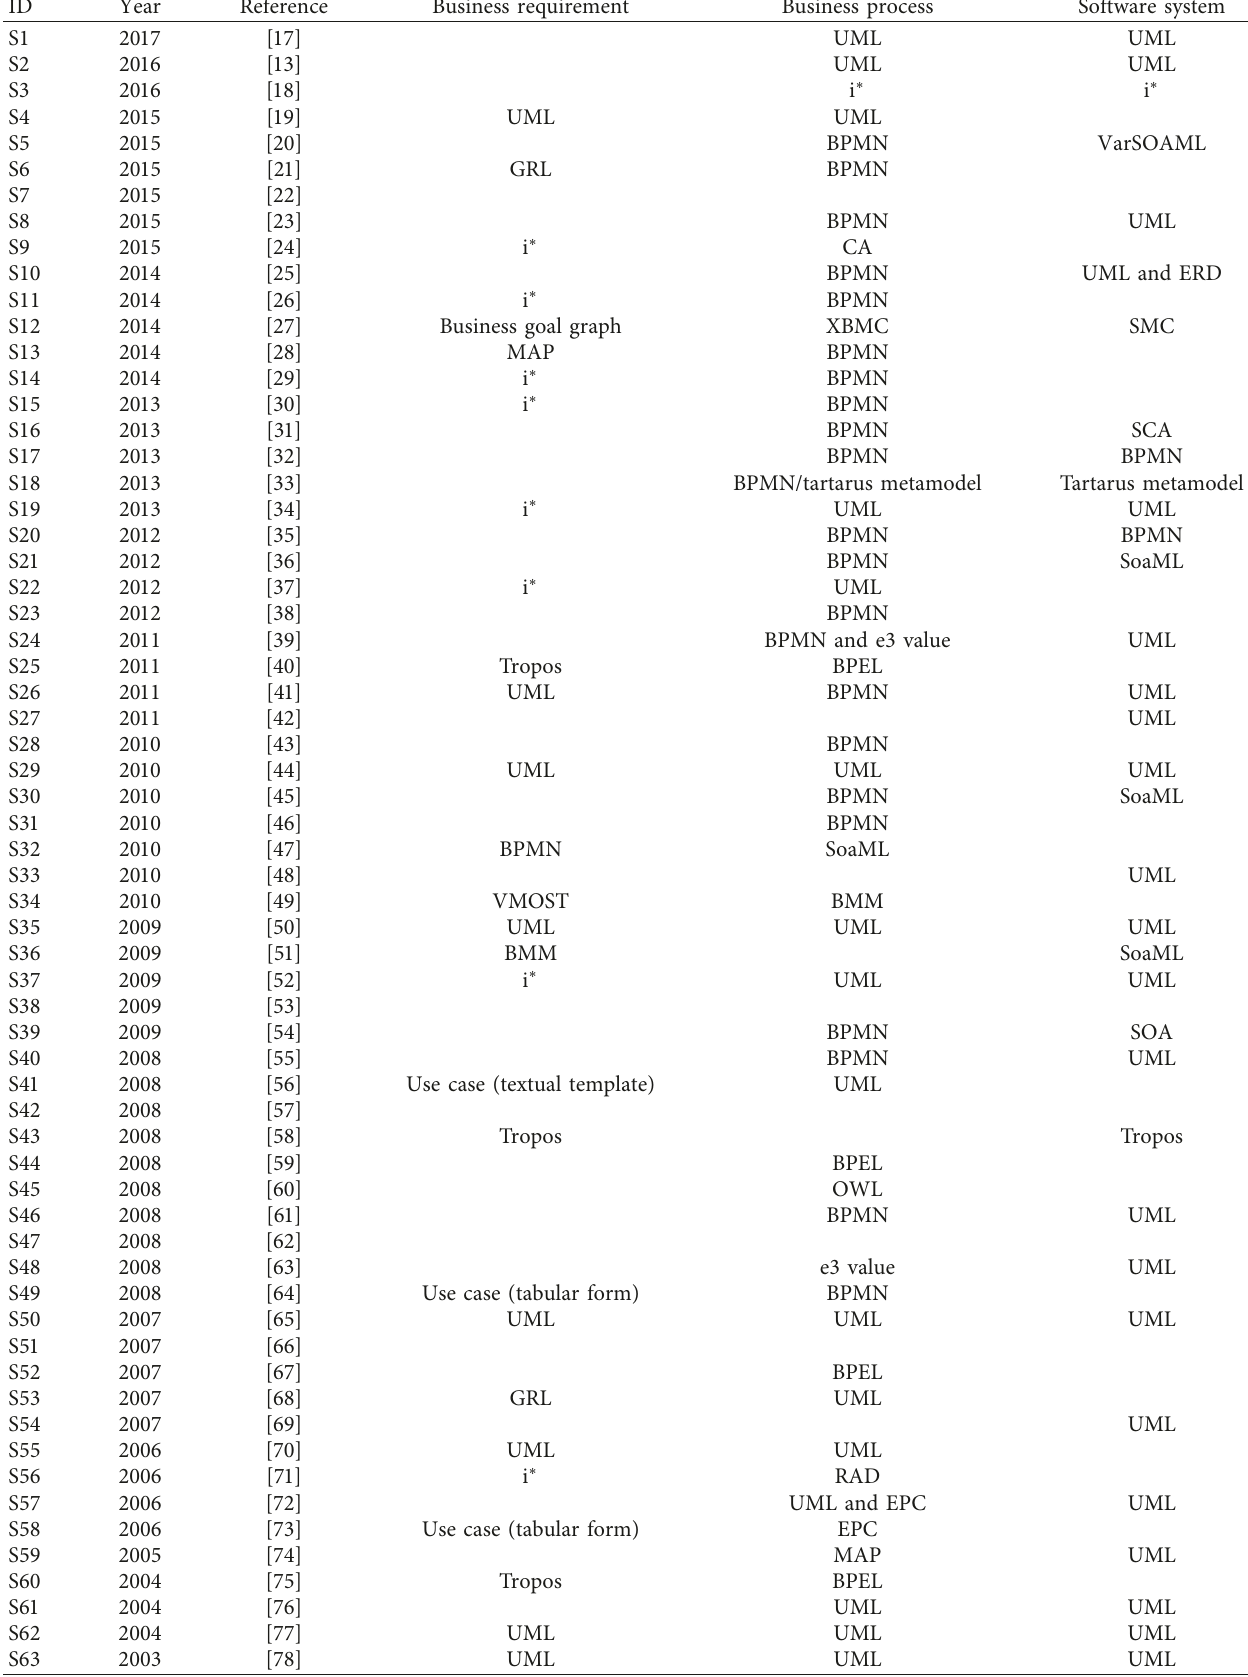
Table 4: Synthesis of models used in each